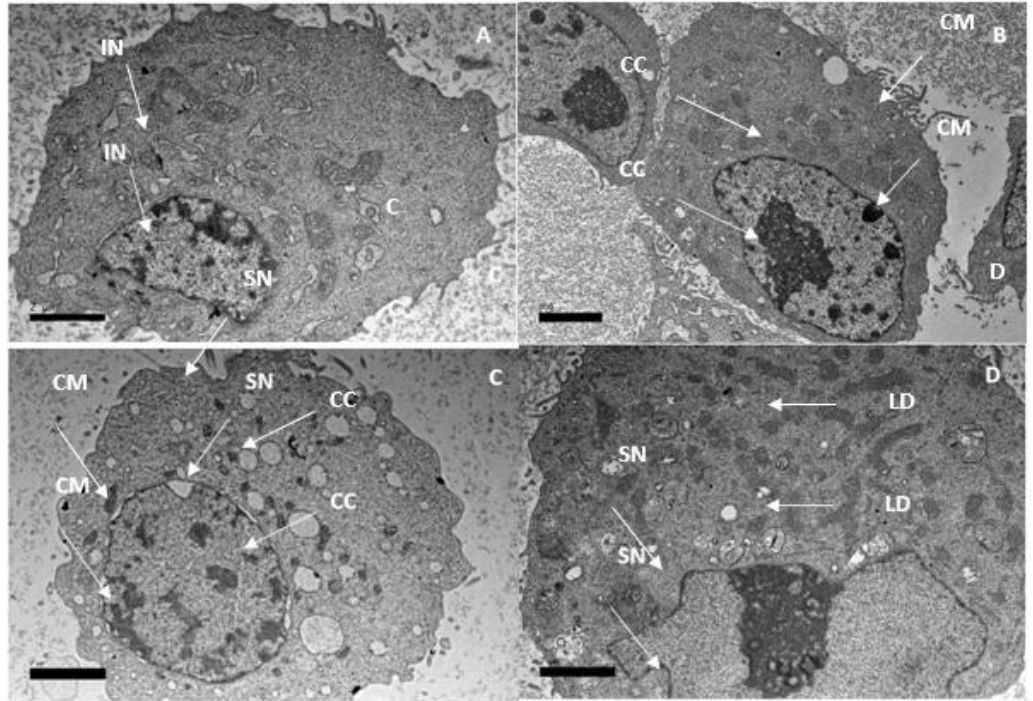
Figure 16. TEM for MDA-MB-231 Cell line. ( A ) control, ( B ) treated cells 24 h, ( C ) 48 h and ( D ) 72 h, respectively. IN, Intact nucleus; CC, chromatin condensation; CM, chromatin margination; SN, shrinkage of nuclei; LD, lipid droplet.